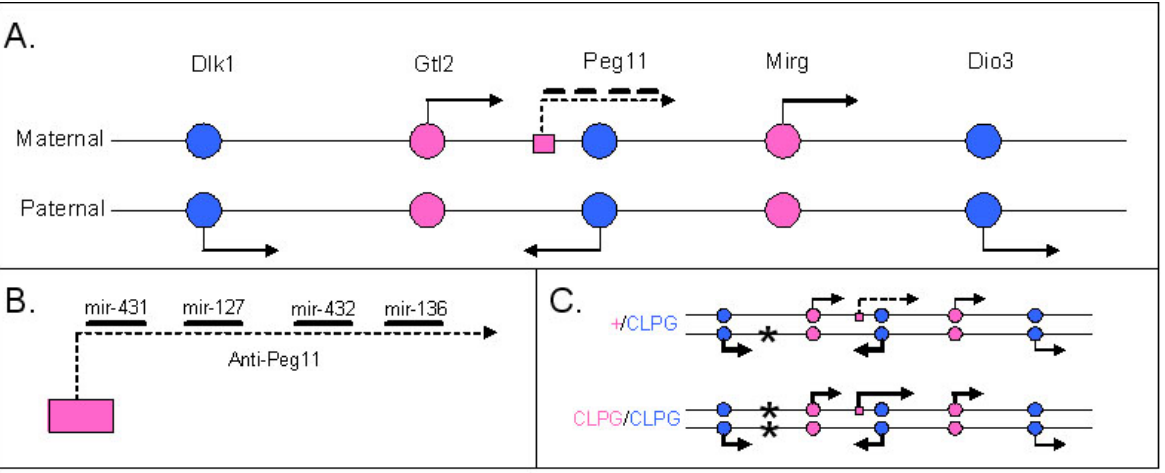
FIGURE 2 . MiRNA expression in the Dlk1-Gtl2 imprinted locus. (A) Schematic representation of the maternal and paternal alleles of the Dlk1- Gtl2 imprinted locus. (B) An enlarged view of the anti-Peg11 transcript including several miRNAs shown to be overexpressed when inherited with the CLPG mutation. (C) The effect of the CLPG mutation on gene expression in the Dlk1-Gtl2 locus. Only wildtype/CLPG (+/CLPG) and CLPG/CLPG are shown. See text for details. Blue circles represent paternally expressed genes. Pink circles represent maternally expressed genes. The maternally expressed anti-Peg11 transcript is depicted as a pink square and a dotted line. Genes that are transcribed are indicated with an arrow. Genes that are overexpressed are depicted by bold arrows. An asterisk (*) marks the CLPG